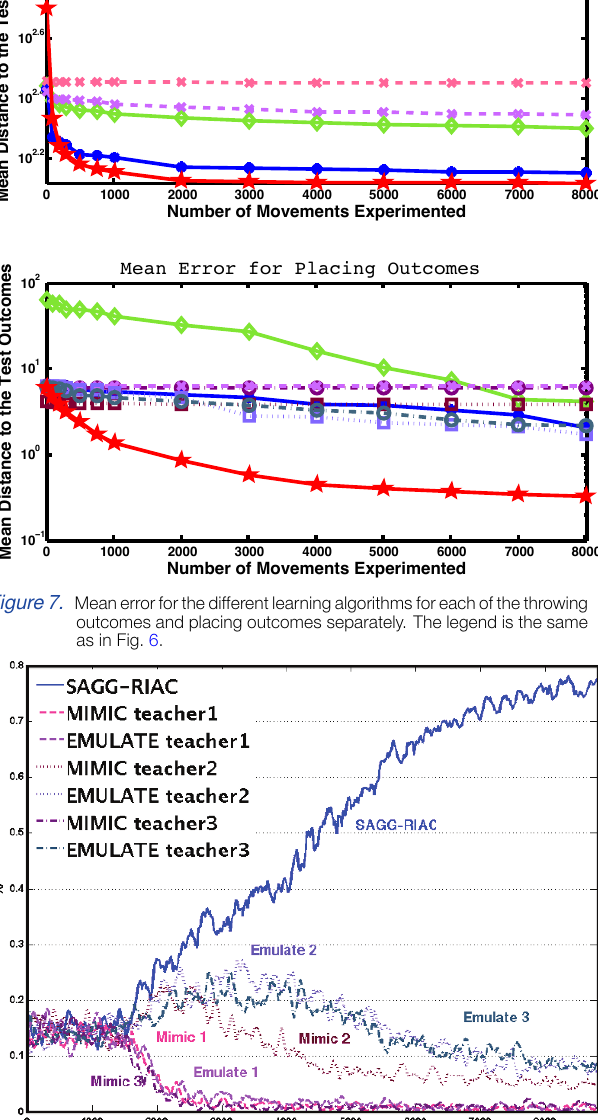
Figure8. StrategychosenbybySGIM-ACTSthroughtime: percentageoftimes each strategy is chosen for several runs of the experiment.